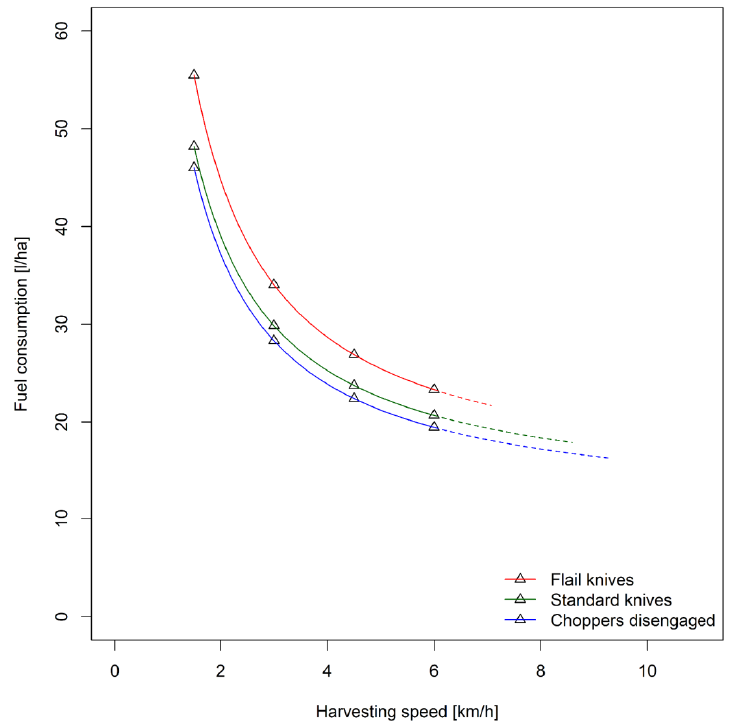
Figure A10. Fuel consumption of the combine harvester depending on harvesting speed for the levels of corn header configuration at cutting height level 3 (Markers indicate harvesting speed levels at cutting height level 3, dashed lines represent extrapolation up to a theoretical engine load of 90%). Agriculture 2023 , 13 , x FOR PEER REVIEW